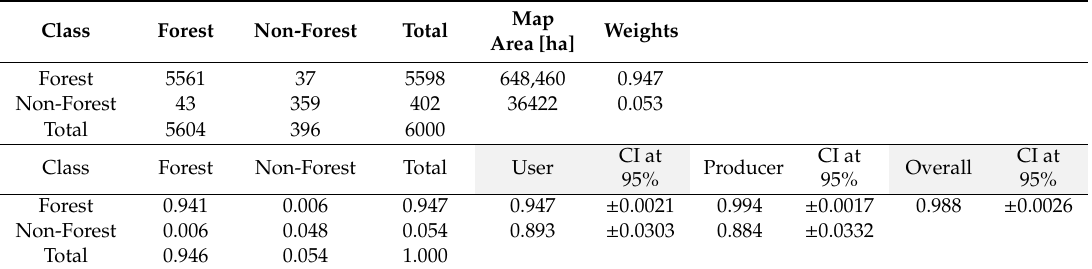
Table A2. Confusion matrix for 2013 FNF map of Gabon (plots and area weights). Map categories are the rows, reference categories are the columns.